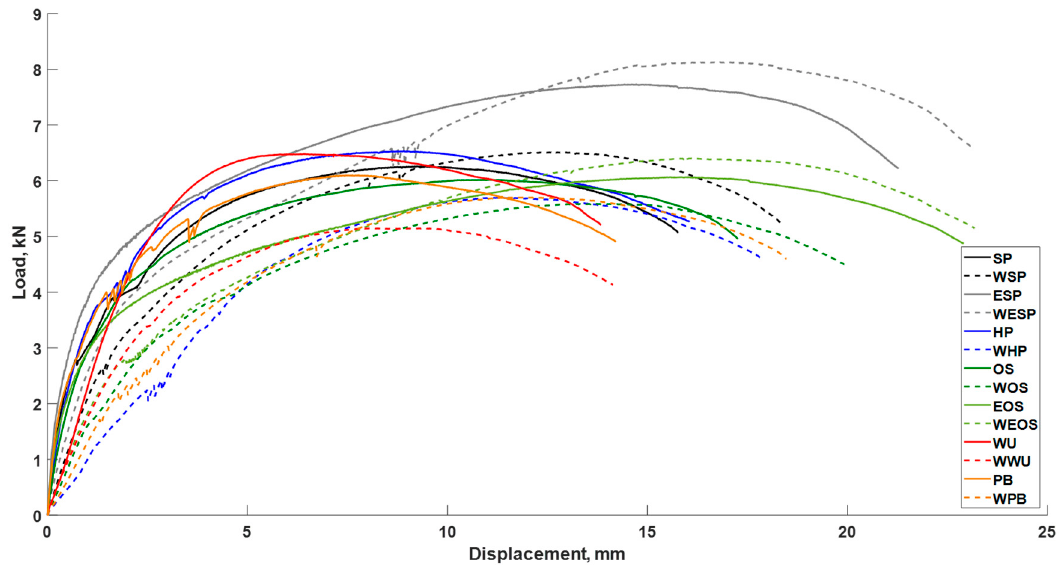
Figure 7. Averaged load–displacement plots by group tested under monotonic loading protocol.